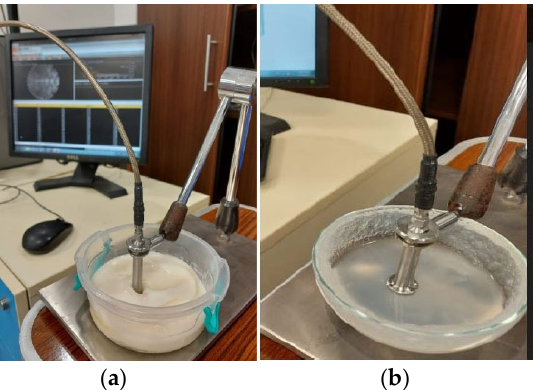
Figure 5. Characterization of fabricated phantoms using DAK dielectric probe station ( a ) breast and ( b ) tumor.